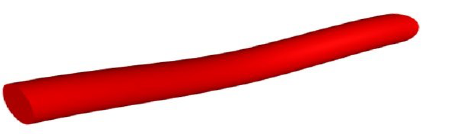
Figure 10. Sample yarn created by specifying 3 nodes with TexGen.